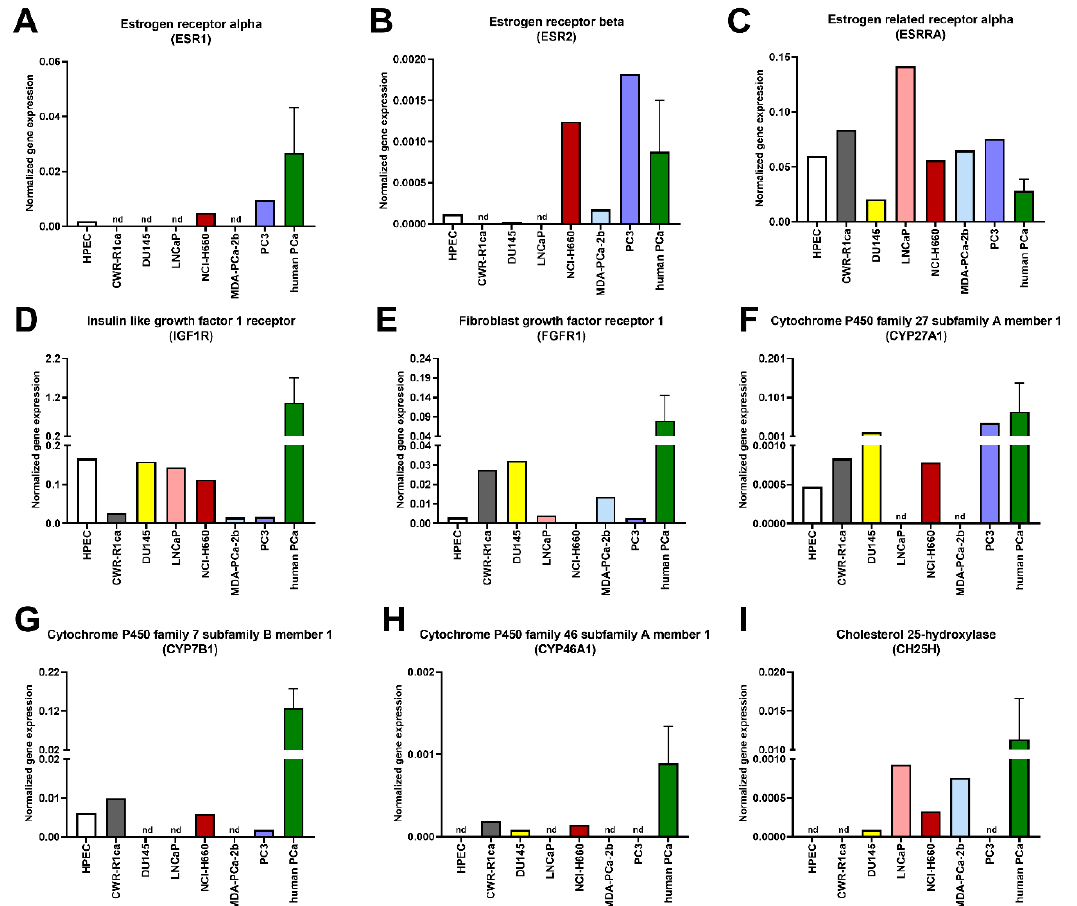
Figure 2. Transcript levels of hormone receptors and potential oncogenic mediators in prostate-cancer cell lines and in human prostate-cancer tissue. Transcript levels of indicated genes were measured using real-time PCR. ( A ) ESR1 , ( B ) ESR2 , ( C ) ESRRA , ( D ) IGF1R , ( E ) FGFR1 , ( F ) CYP27A1 , ( G ) CYP7B1 , ( H ) CYP46A1 , ( I ) CH25H . PCa: prostate cancer, HPEC: parental primary prostate cells, CWR-R1ca: xenograft PCa cells, DU145: brain metastasis PCa cells, LNCaP: lymph-node metastasis PCa cells, NCI-H660: lymph-node metastasis PCa cells, MDA-PCa-2b: bone metastasis PCa cells, PC3: bone metastasis PCa cells, nd: not detected. For human PCa samples, data shown as pooled samples: mean ± standard deviation ( n =